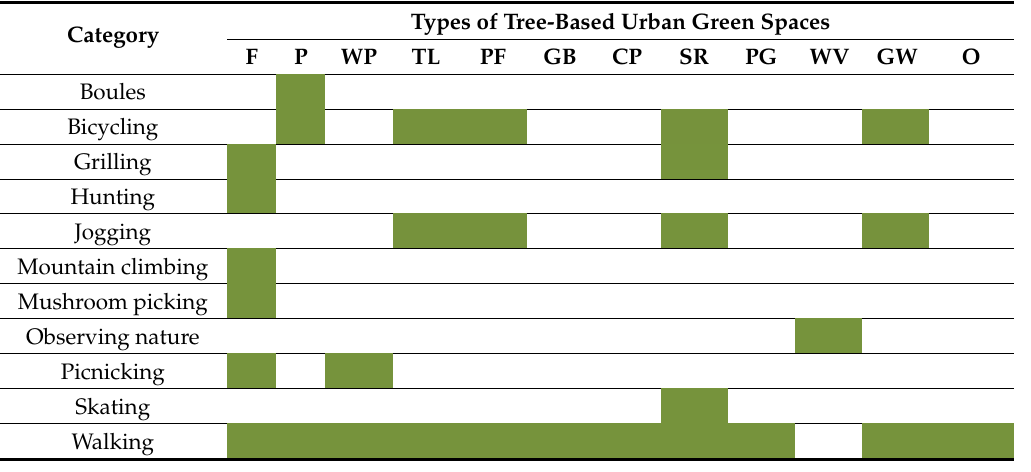
Table 5. Recreational use of tree-based urban green spaces (UGSs). Green indicates the assignation of recreational activity to a particular type of UGS (F—forest, P—park, WP—walking paths along the streams, TL—tree lines, PF—park forest, GB—greenery around residential buildings, CP—children playgrounds, SR—greenery of sports and recreational facilities, PG—private